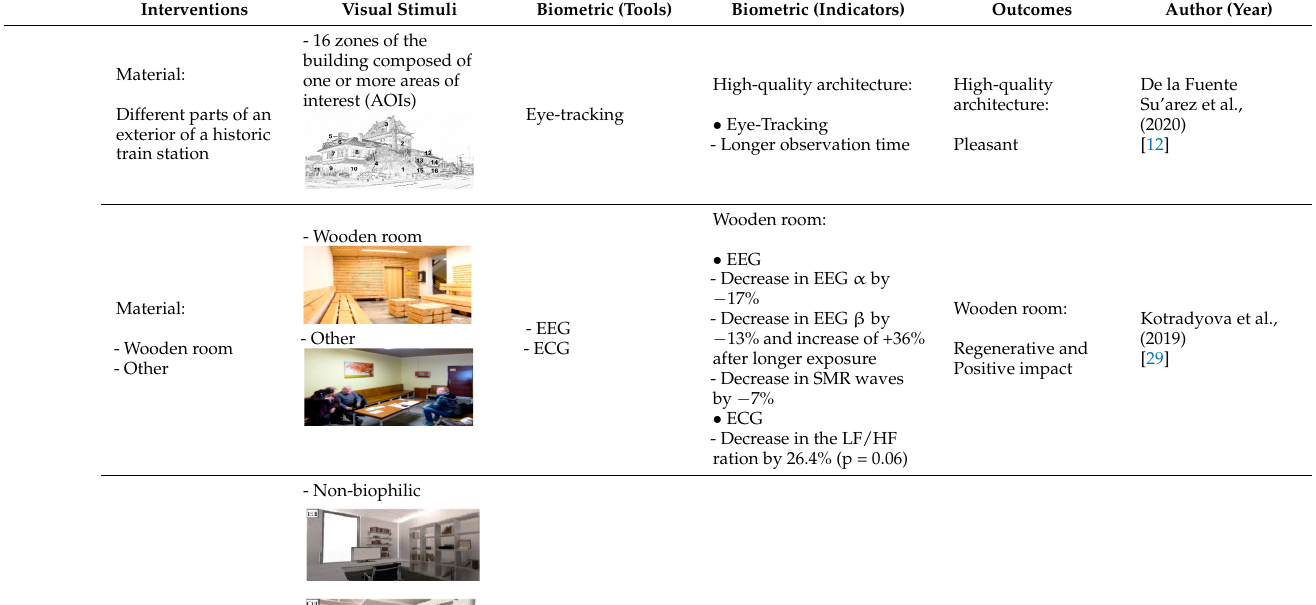
Biophilia: • SCL - Decrease • Eye-tracking - Spend more time